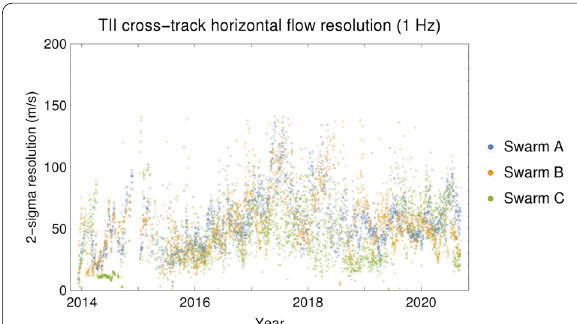
Fig. 16 Daily TII 2 σ velocity resolution from the version 0302 cross-track ion flow